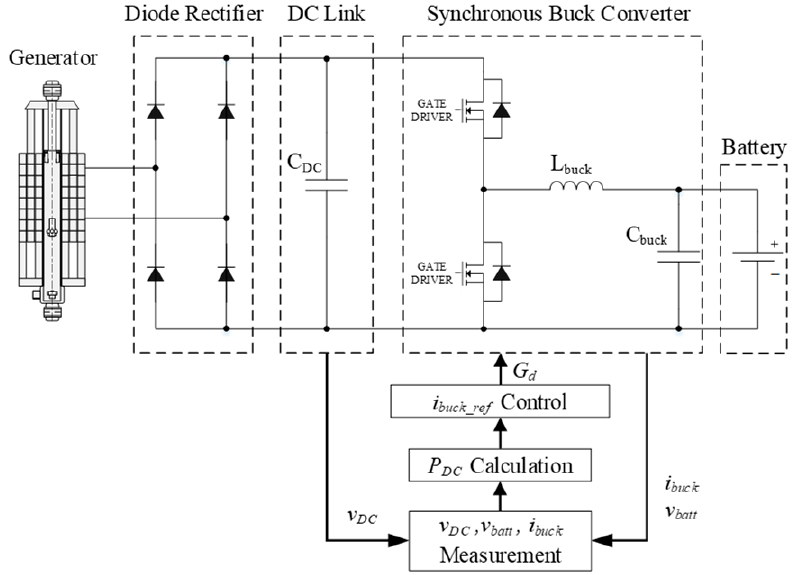
Figure 4. Overall structure of an active power converter using the MPPT algorithm.